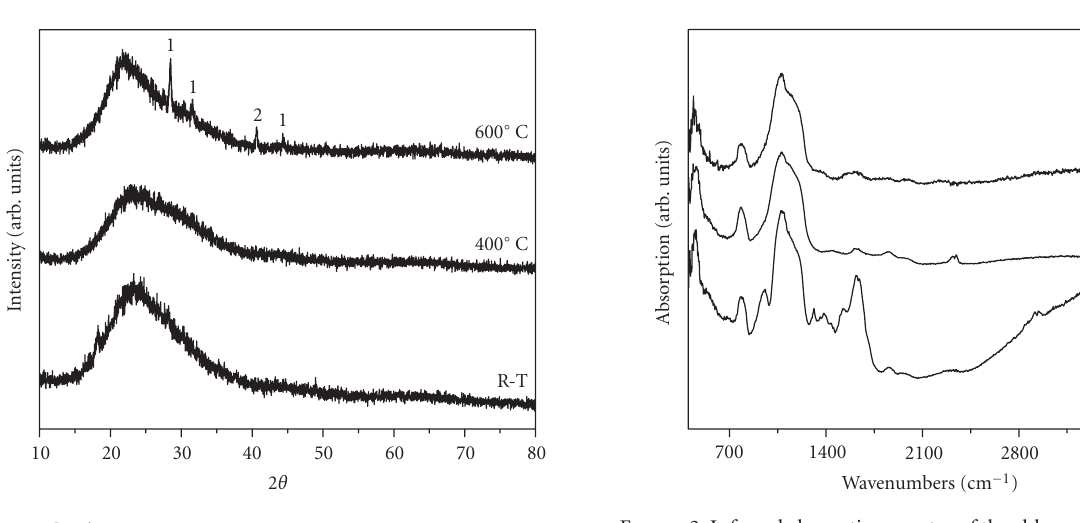
Figure 3: Infrared absorption spectra of the chlorophyll-containing silica xerogel